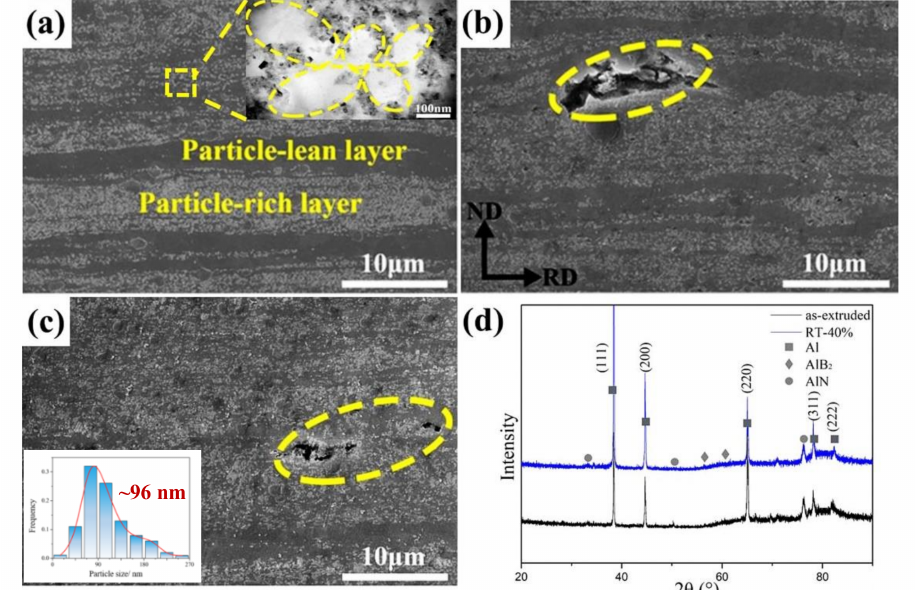
Figure 1. Microstructures and phase identification of AlN / Al composites with di ff erent rolling reductions at room temperature: ( a ) as-received sample; ( b ) 16%; ( c ) 40%, the inset showing the size distribution of AlN particles; ( d ) X-ray di ff raction (XRD) patterns of as-received sample and